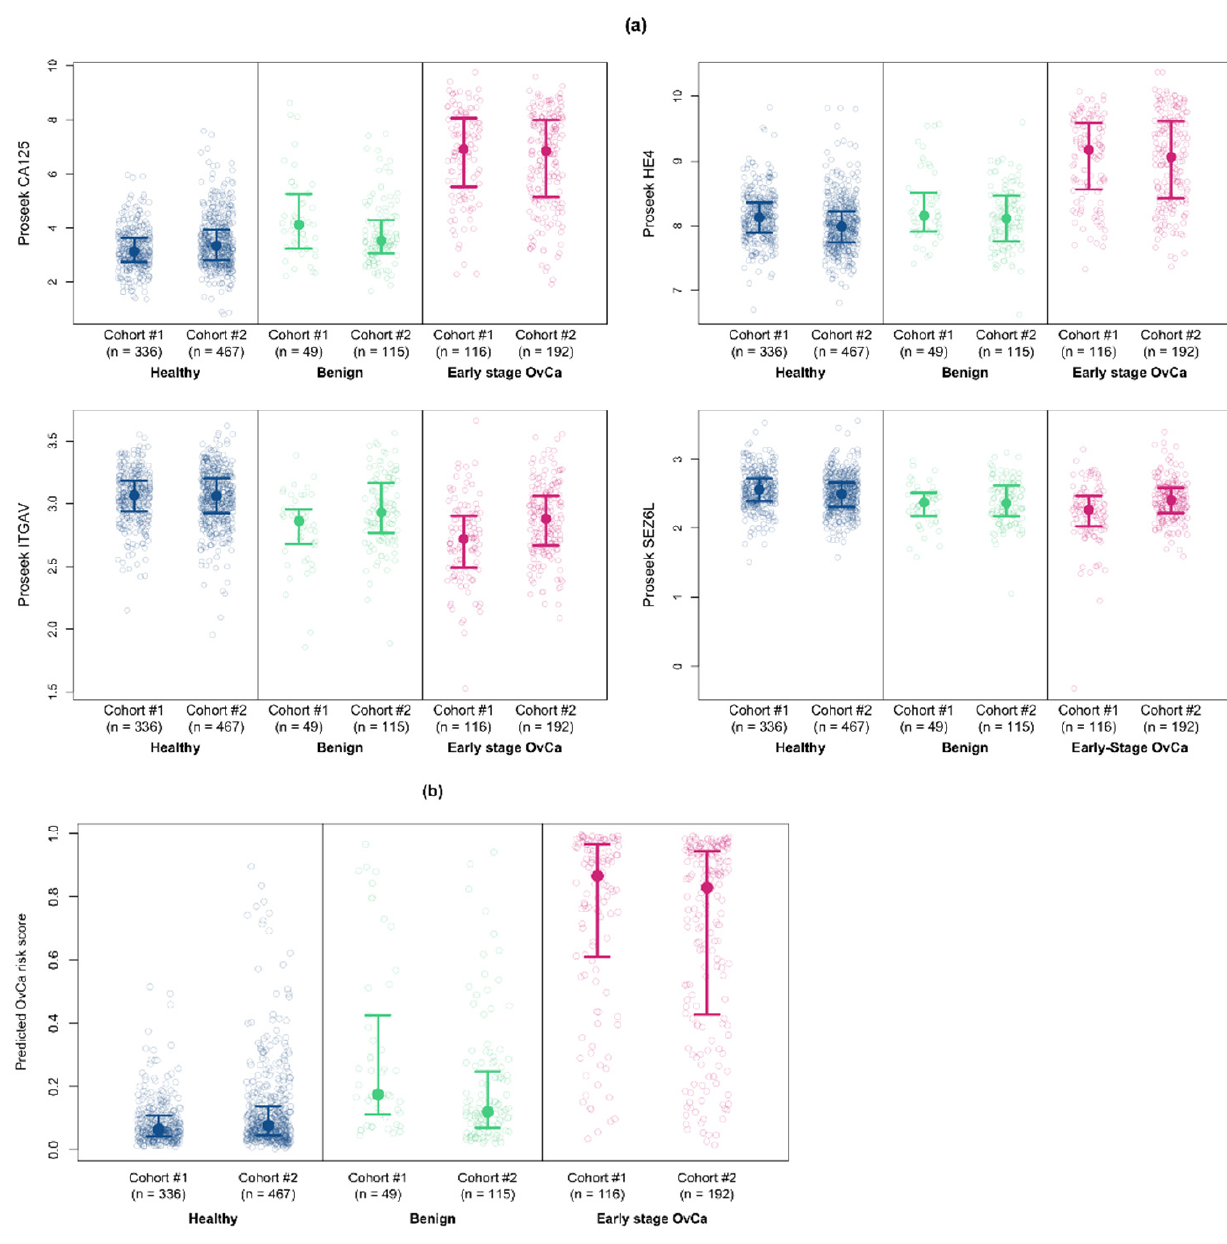
Figure 5. Validation of the multiprotein classifier with serum samples from women with benign ovarian conditions. ( a ) Comparison of the NPX values for the proteins included in the multiprotein classifier between healthy controls, benign samples, and the early stage ovarian cancer samples from both cohorts of samples. ( b ) Predicted cancer risk scores stratified by true cancer status for the early stage ovarian cancer, benign, and healthy control samples from Cohort #1 and Cohort #2. The median and 25th/75th percentiles are shown in all plots.